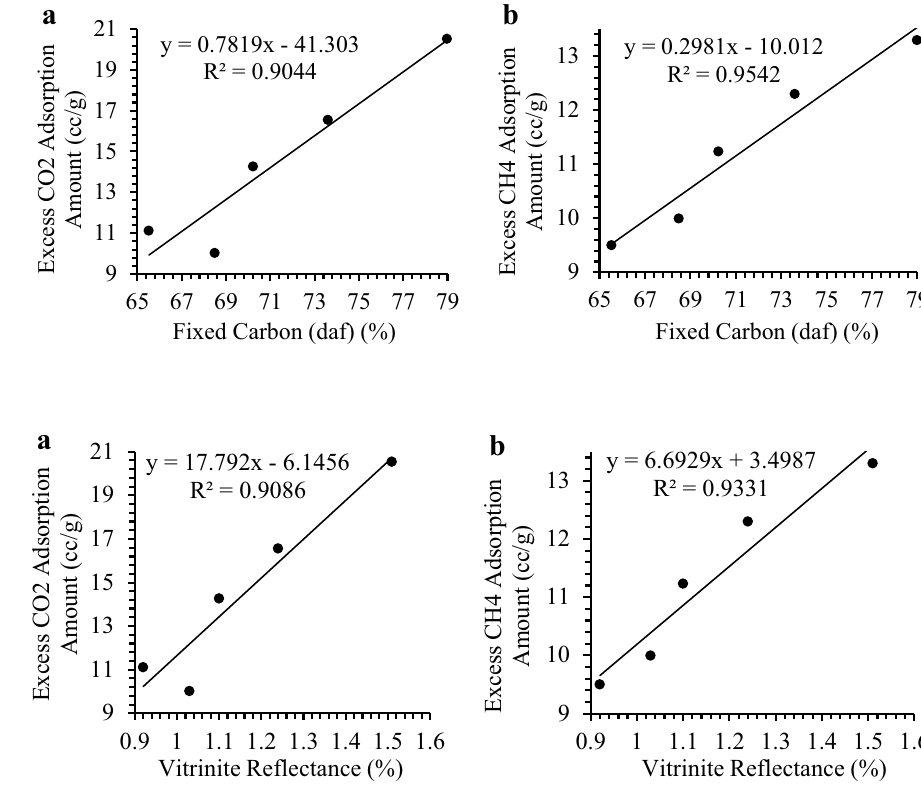
Fig. 12 Effect of vitrinite reflectance on sorption capacity of coal. a CO 2 sorption and b CH 4